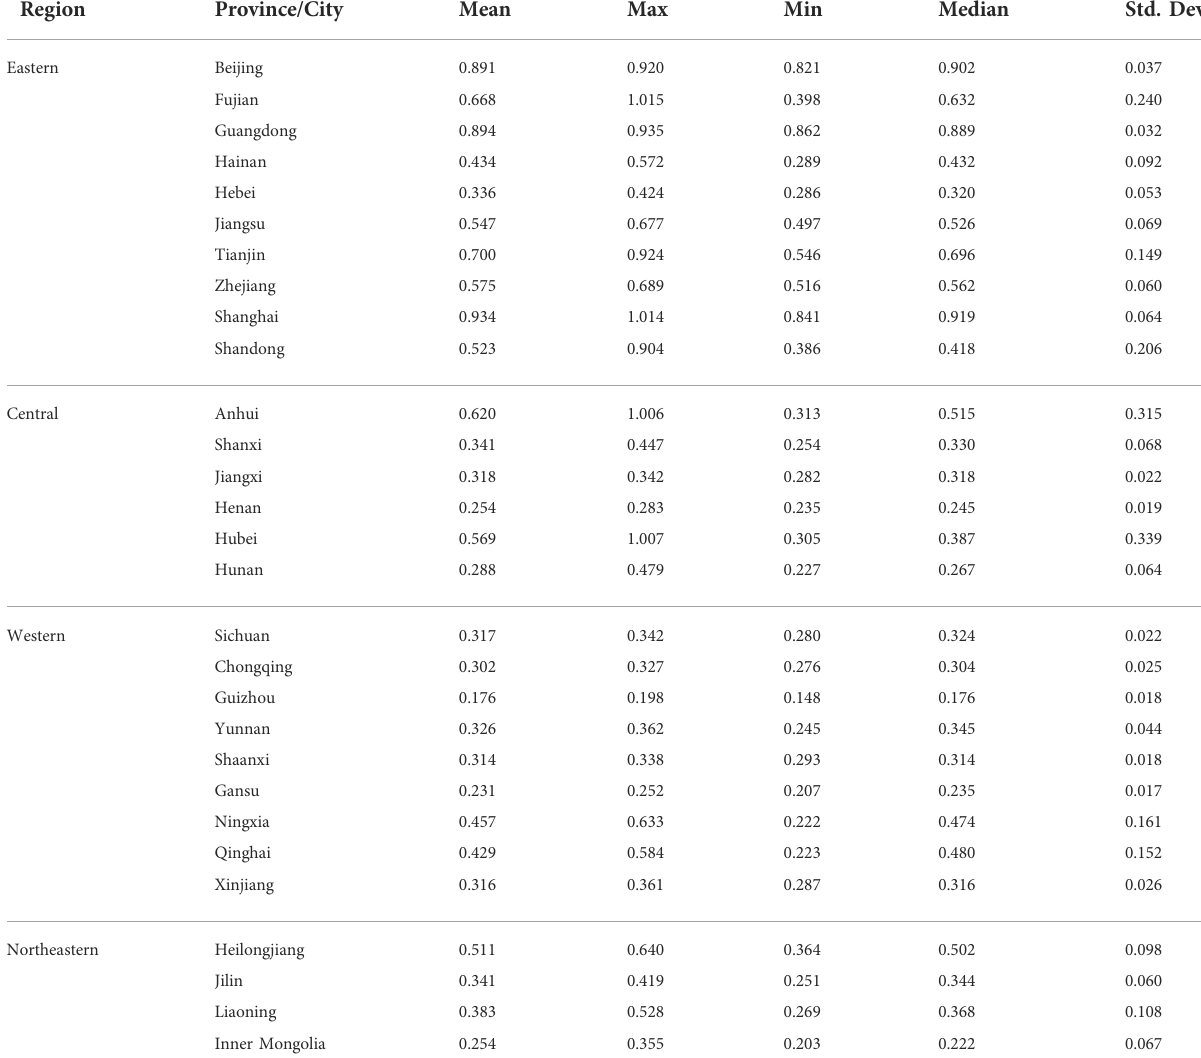
TABLE 1 Statistical descriptions of eco-ef fi ciency in each region of China from 2000 to 2006.